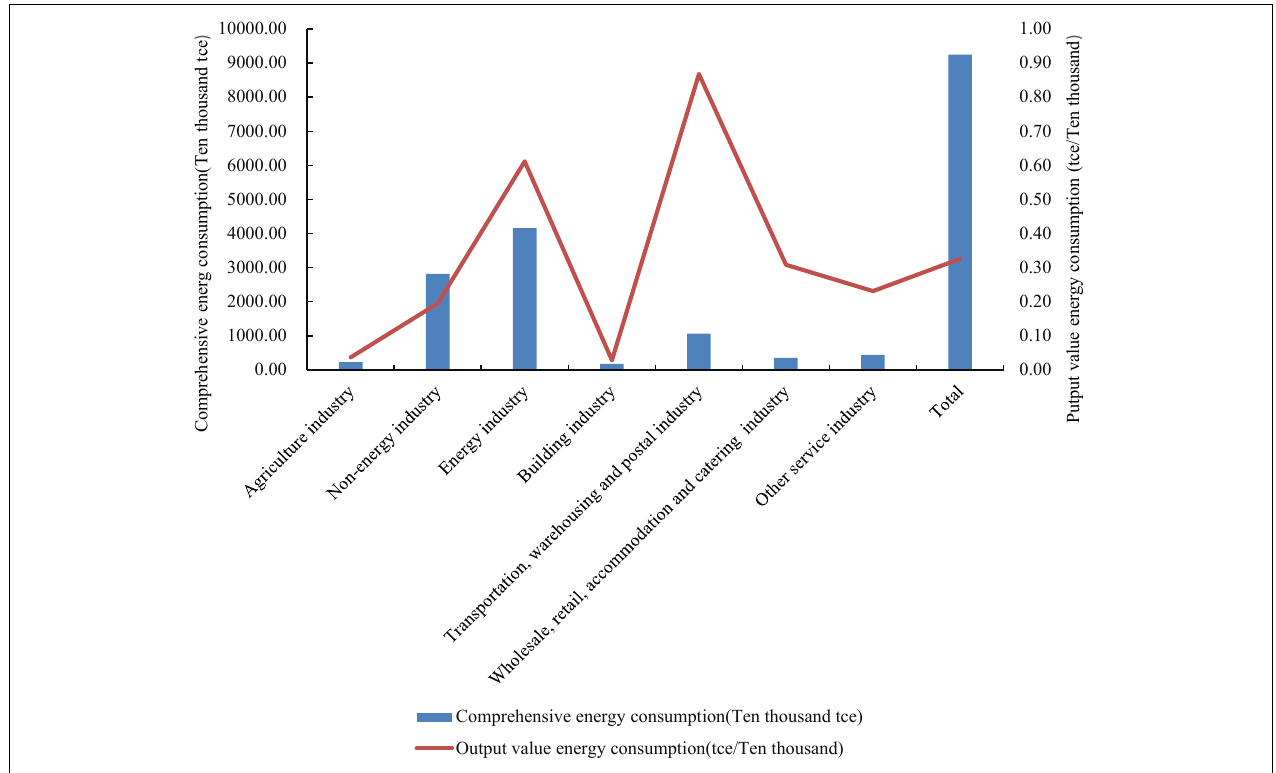
FIGURE 2 | Energy consumption analysis of various industries in Shaanxi Province in